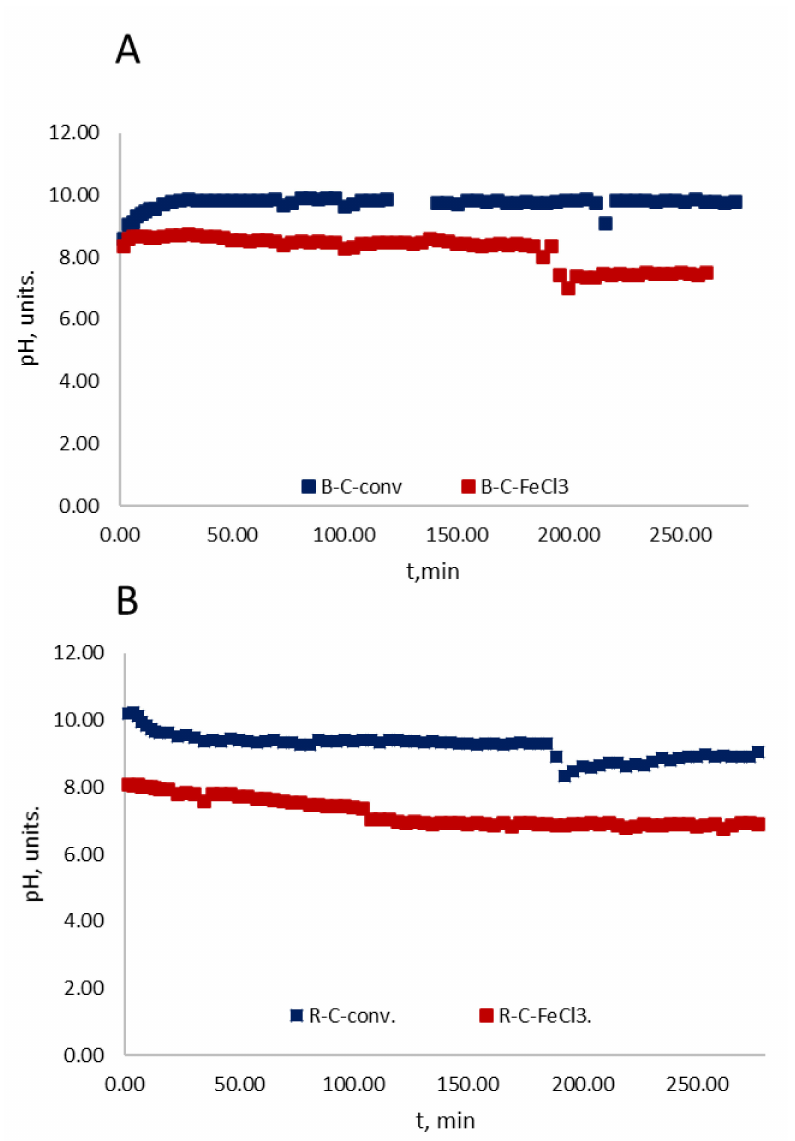
Figure 8. ( A ) Bordeaux B and ( B ) Red G pH performance outside the adsorption column with respect to time in minutes on C -conv and C - FeCl 3